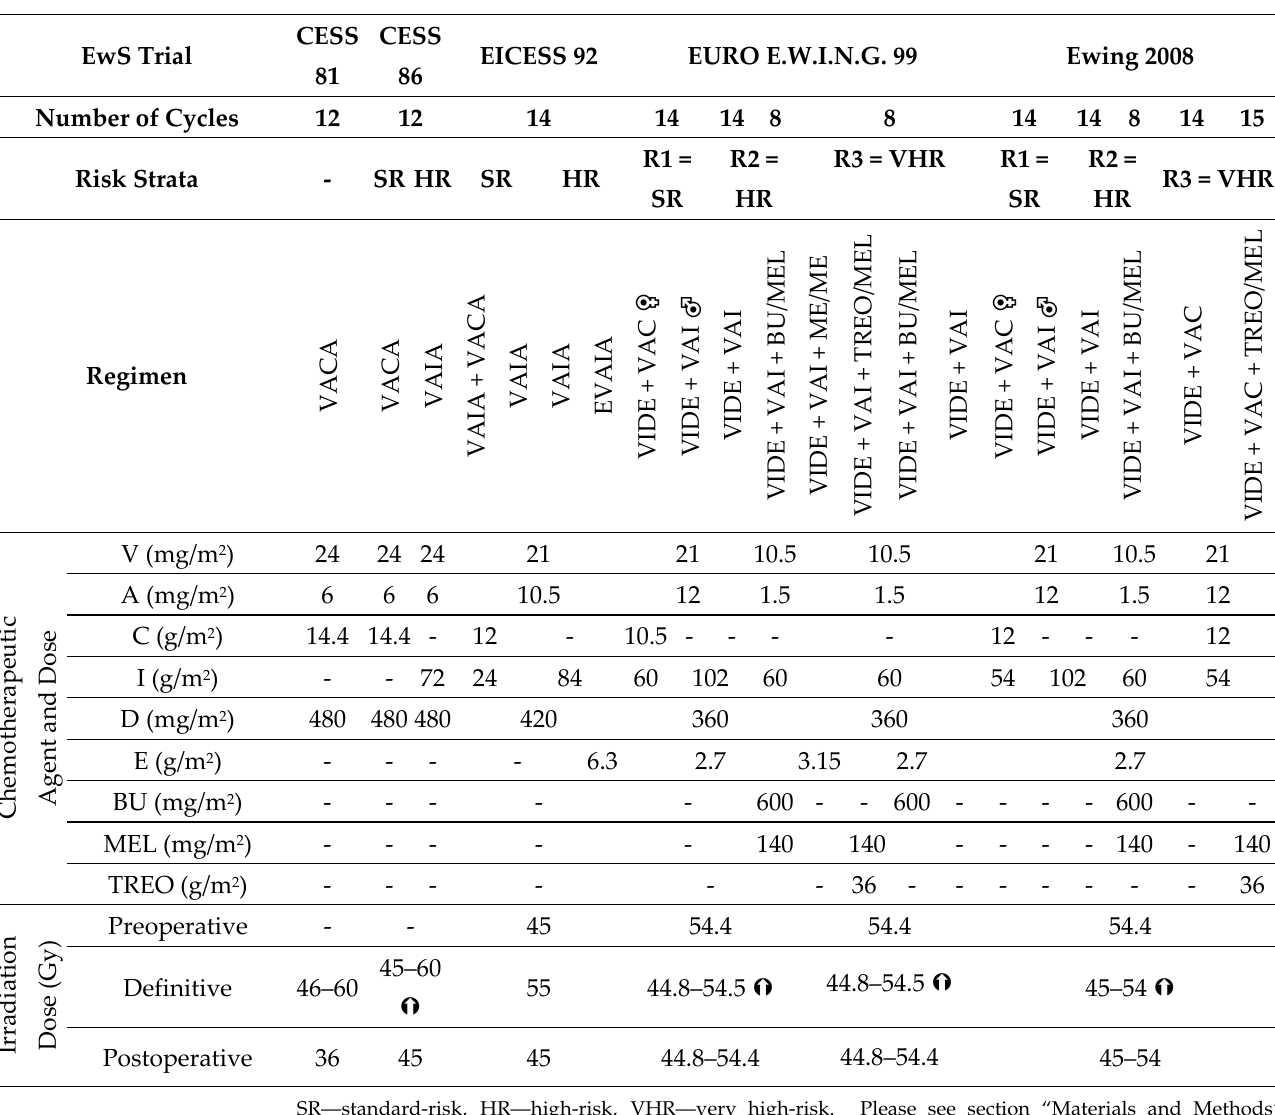
Table 1. Development of chemotherapy and radiotherapy for Ewing sarcoma (EwS) in different trials from the Cooperative Ewing Sarcoma Study (CESS) group.